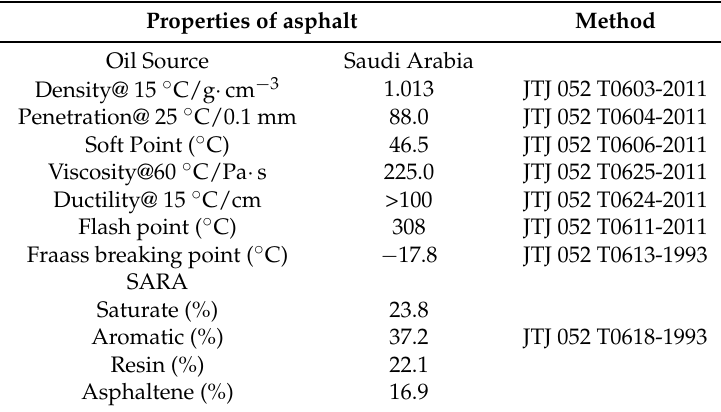
Table 1. Specification of base asphalt.